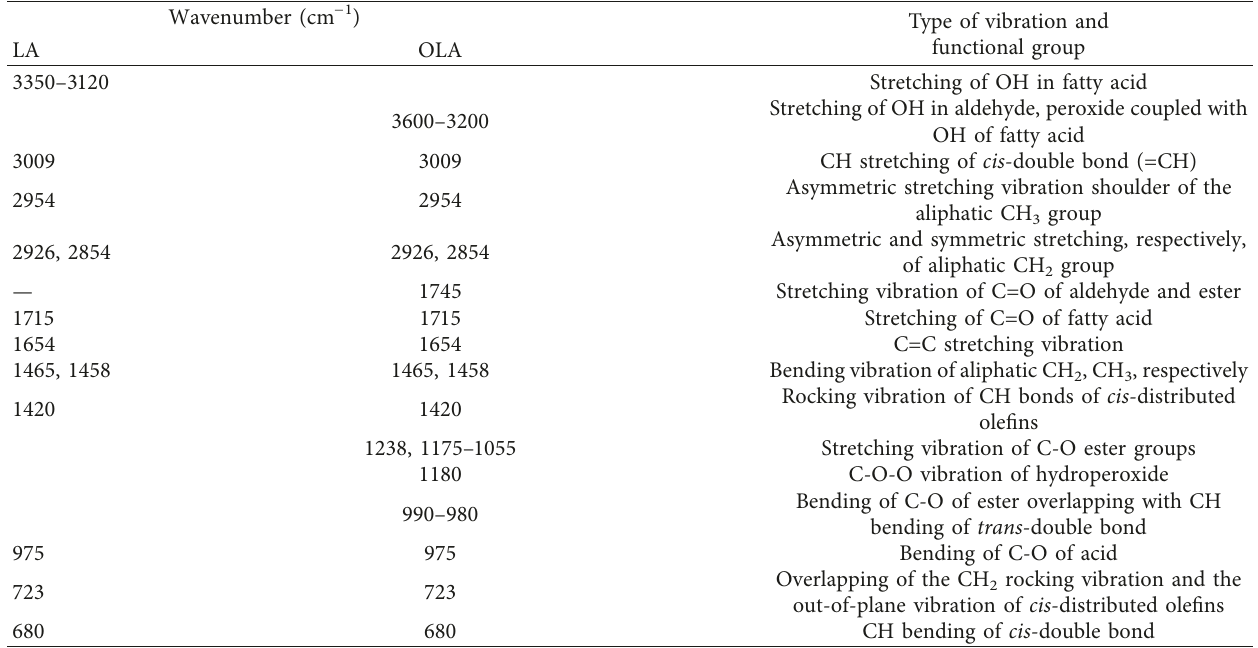
Table 1: Functional group assignment on major absorption bands occurring in the infrared spectra of nonoxidized linoleic acid (LA) and oxidized linoleic acid